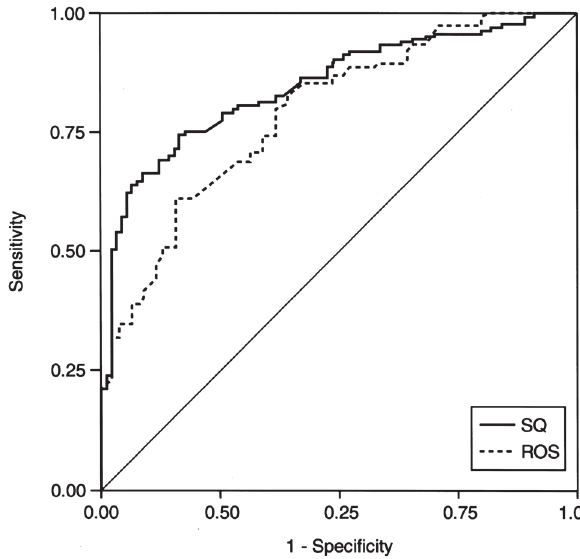
Figure 2 - Receiver operating characteristic curves showing the area under curve in male factor infertility patients and normal healthy donors using semen quality score and reactive oxygen species